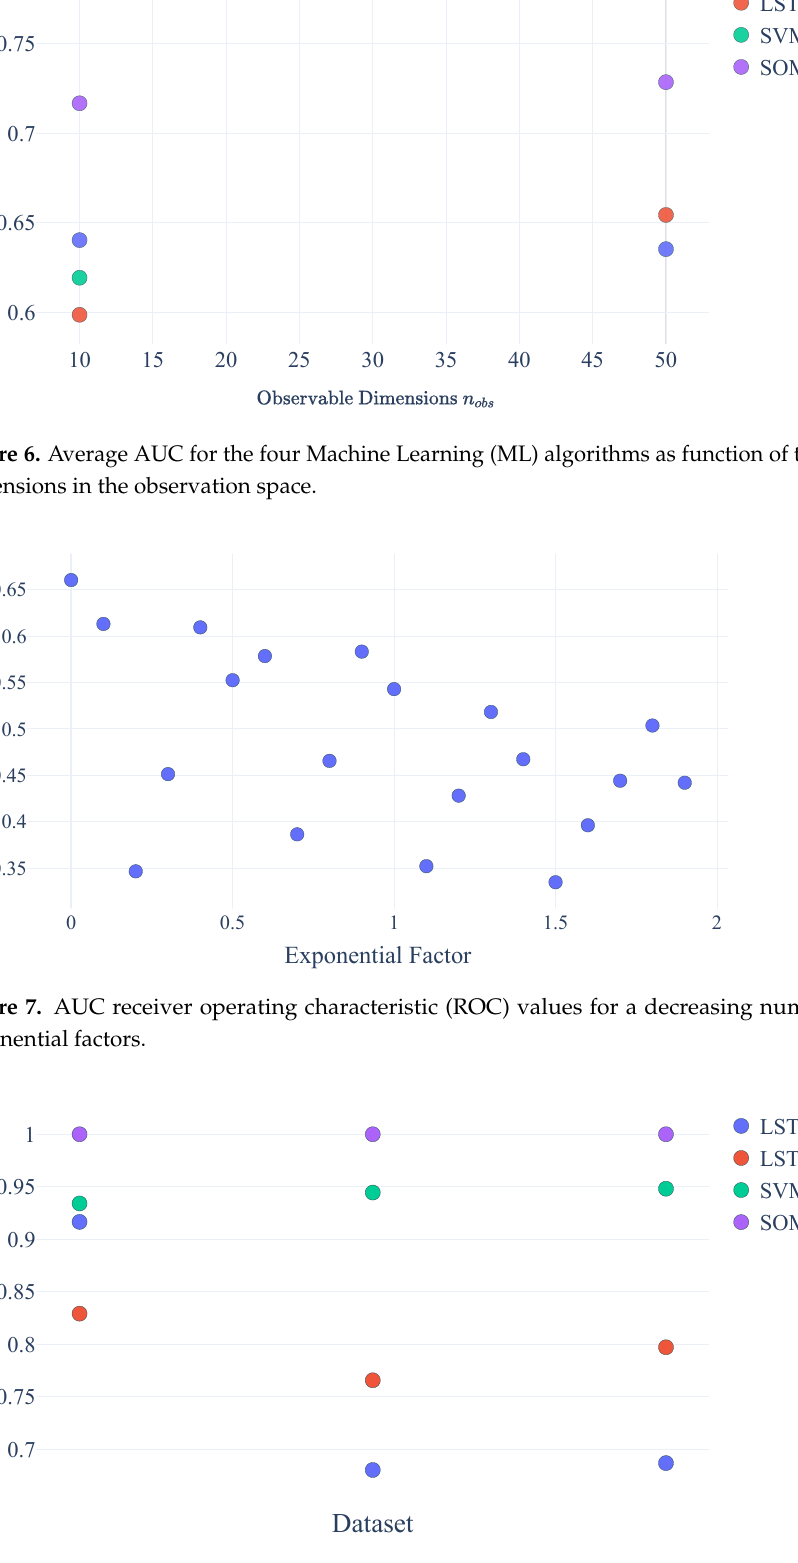
Figure 8. AUC ROC values for real world